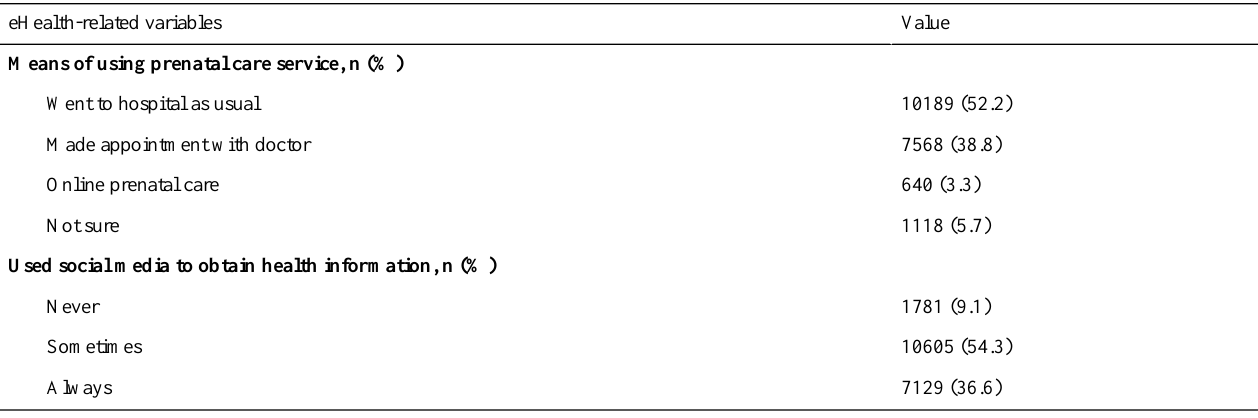
Table 2. Sociodemographic and maternal characteristics of the participants (N=19,515) based on eHealth-related variables. ValueeHealth-related variables Means of using prenatal care service, n (%)